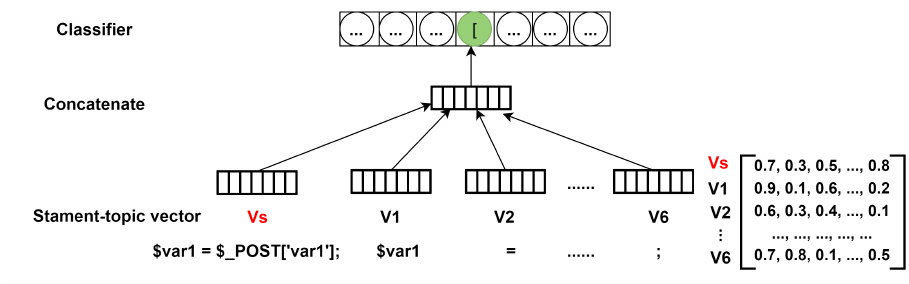
Figure 4. Doc2vec.